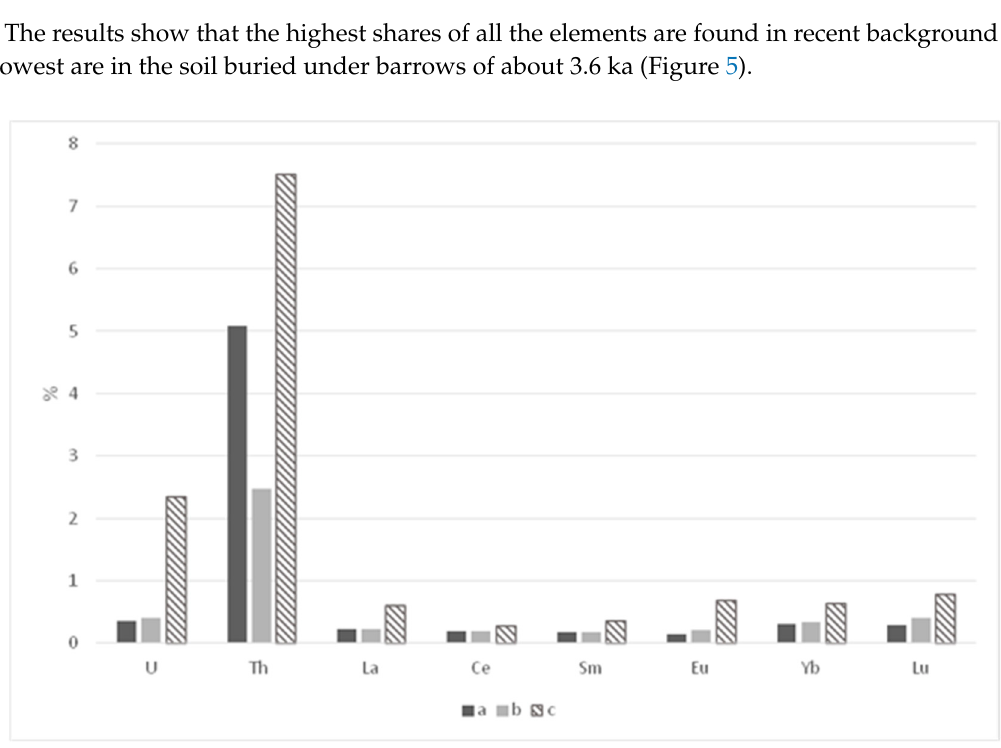
Figure 5. Humic acid contribution in the soil pool of lanthanides, uranium and thorium: ( a ) paleosols under barrows; ( b ) paleosols of settlement; ( c ) recent background soils.